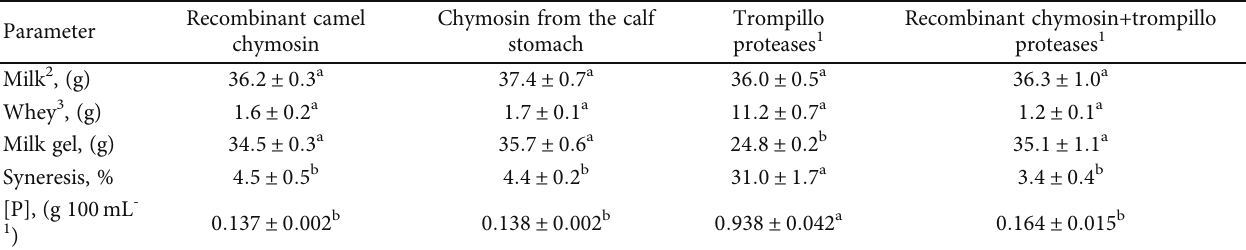
Figure 6: Hydrolysis of milk proteins during gel formation at 30 ° C under the action of di ff erent proteases. (a) Milk clotted with trompillo proteases. (b) Milk clotted with recombinant camel chymosin (lane 1) and chymosin from calf stomach (lane 2); samples were taken after 80 minutes of incubation. MWM=molecular weight marker, a=transferrin, b=serum albumin, c= β -caseins, d= α Table 4: Whey separation in milk gels clotted at 30 ° C with di ff erent proteases.